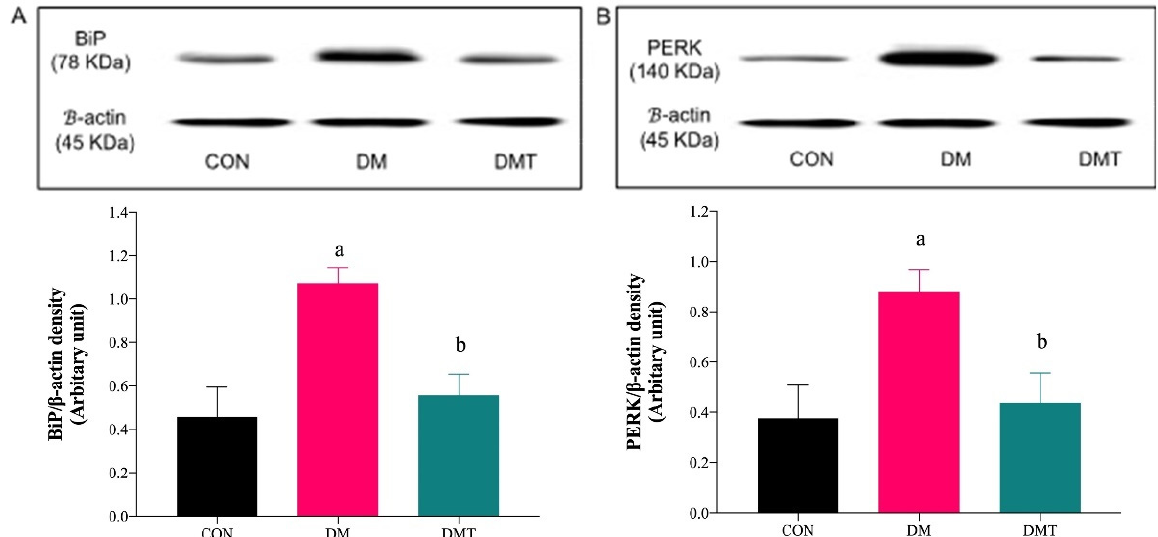
Figure 3. Representative blots showing the density of the protein bands for ( A ) BiP and ( B ) PERK in rat aorta. Graphical representations of the data are normalised to β -actin (n = 9). a p < 0.05 vs. CON, b p < 0.05 vs. DM. Abbreviation: CON; Control, DM; Diabetes, DMT; Diabetes receiving TUDCA, BiP; Binding immunoglobulin protein, and PERK; Protein kinase-like ER kinase.